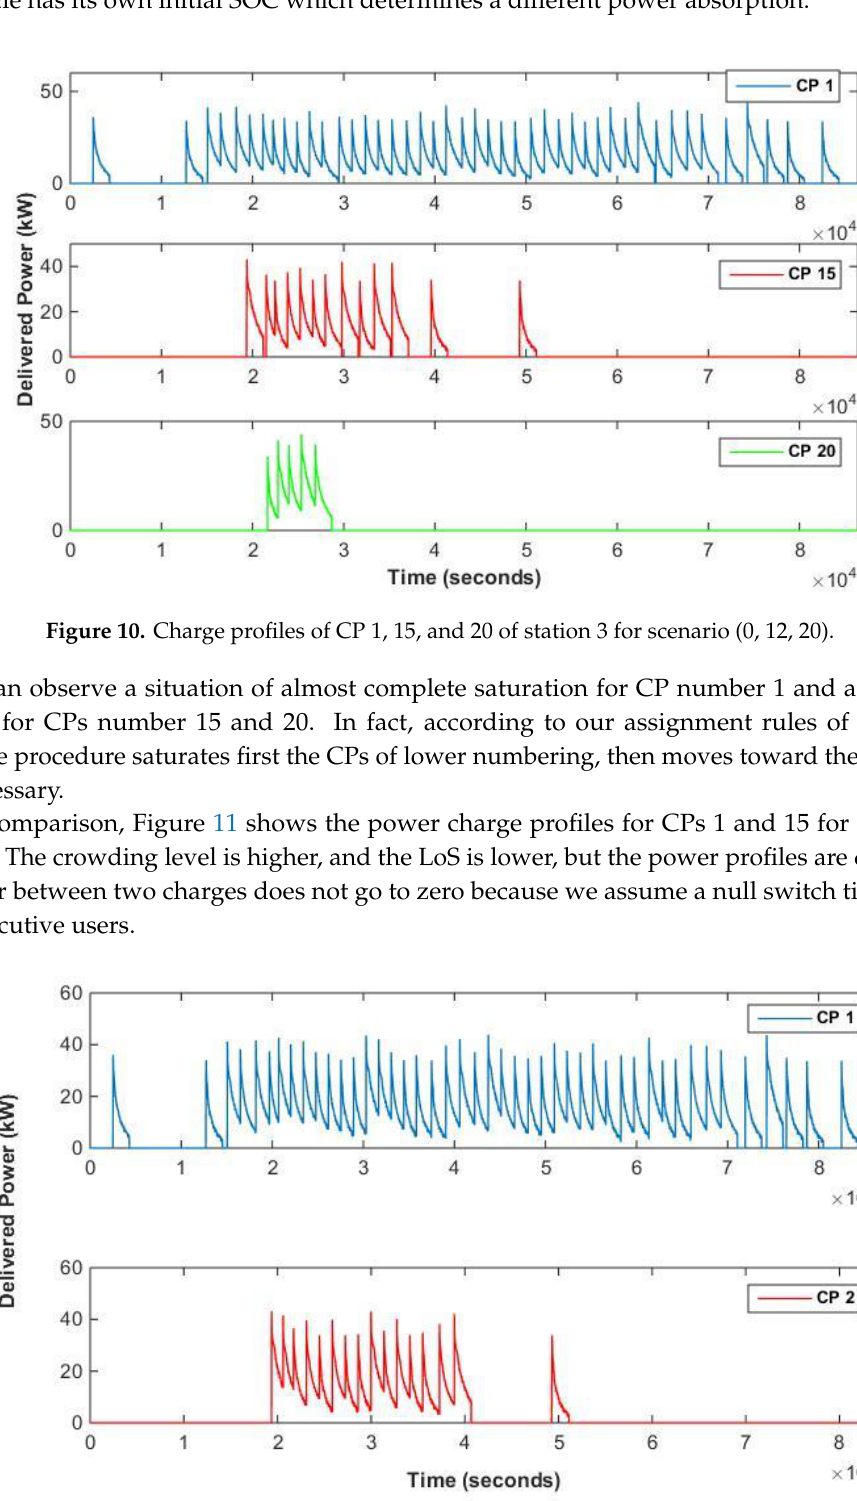
345.49 Table 7. Weekly energy demand for the stations in different scenarios . Scenario